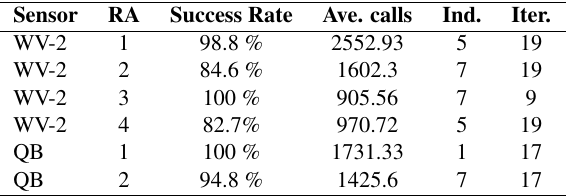
Table 4. Experimental Results - Optimum